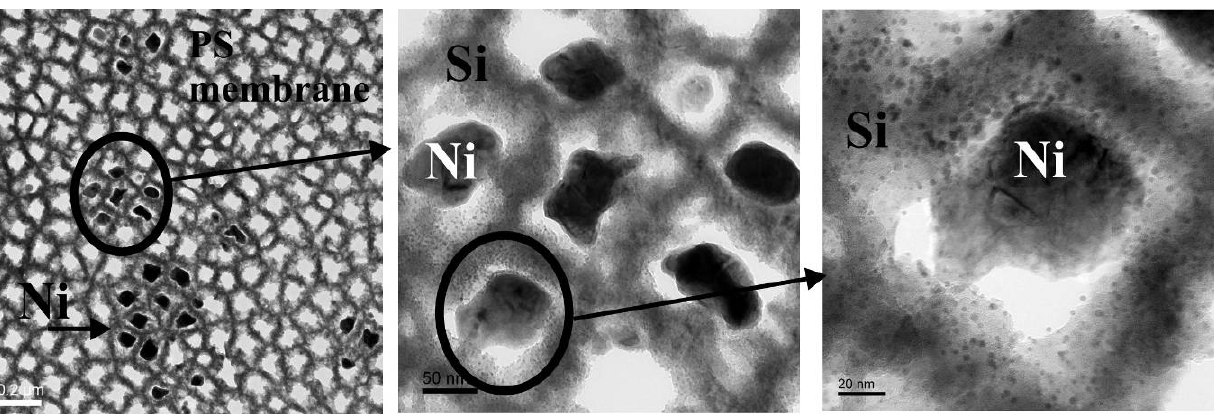
Figure 36. From left: TEM-image of a Ni-filled porous silicon membrane. Ni-particles can be seen inside the pores. Middle: zero-loss image of an enhanced region showing the Ni- structures within the PS-matrix. Right: HRTEM-image showing an individual Ni-particle inside a pore and the surrounding